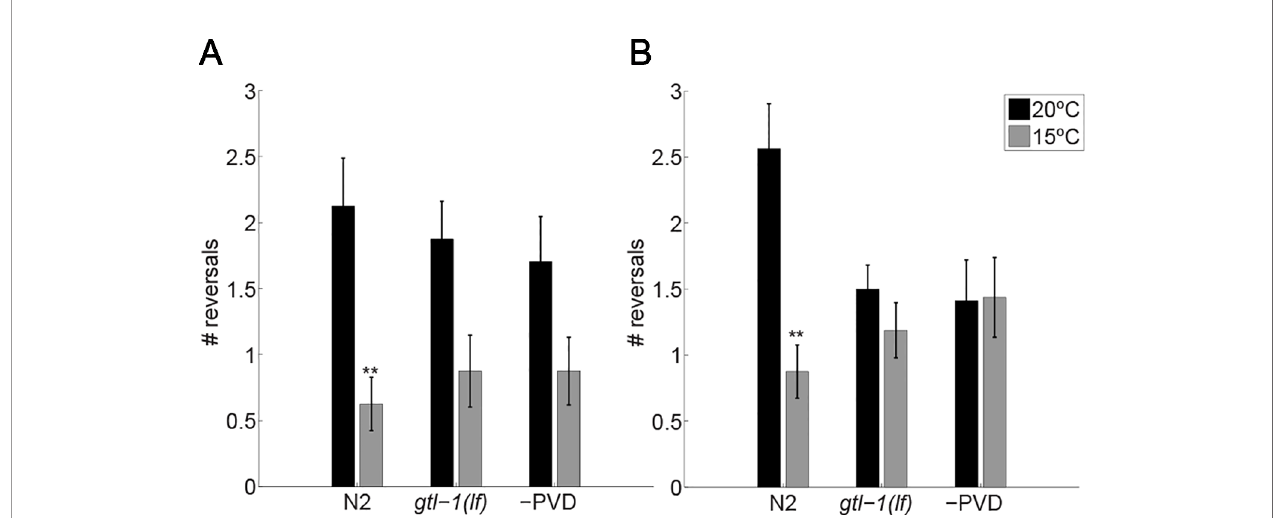
FIGURE 2 | GTL-1 is required for the immediate and enduring response to cold temperatures. Number of reversals was counted over 30 sec immediately after the temperature drop (A) and 10 min later (B) . n = 16 each. Signi fi cant differences relative to controls, maintained at 20°C (black bars) throughout the experiments, were examined using two-way ANOVA **-p<